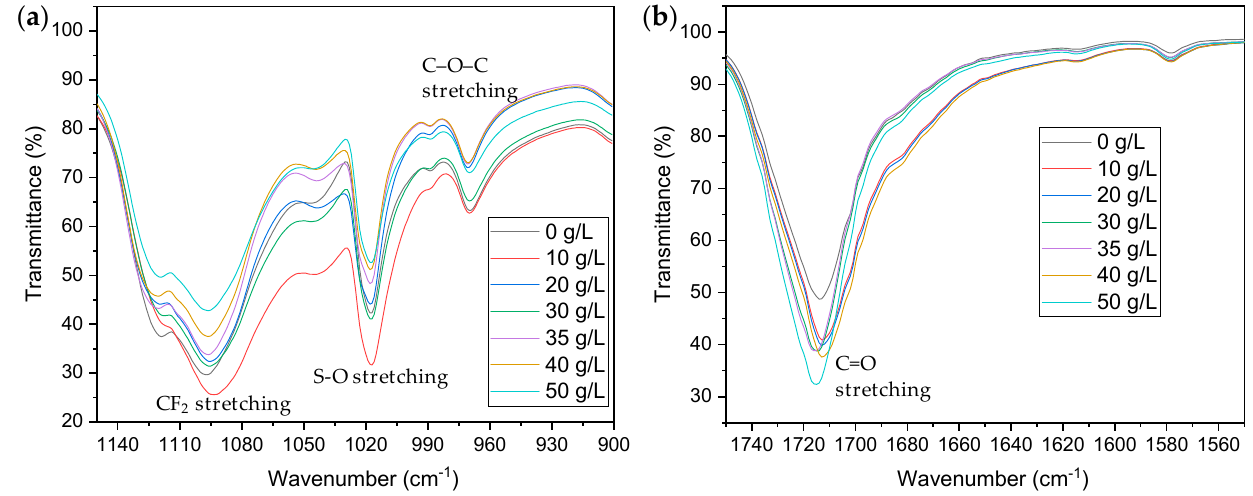
Figure 2. FTIR spectra of Nafion membranes after ex situ accelerated degradation in the presence of different NaCl concentrations: ( a ) for wavenumber ranging from 900–1150 cm − 1 ; ( b ) for wavenumber ranging from 1550–1750 cm − 1 .